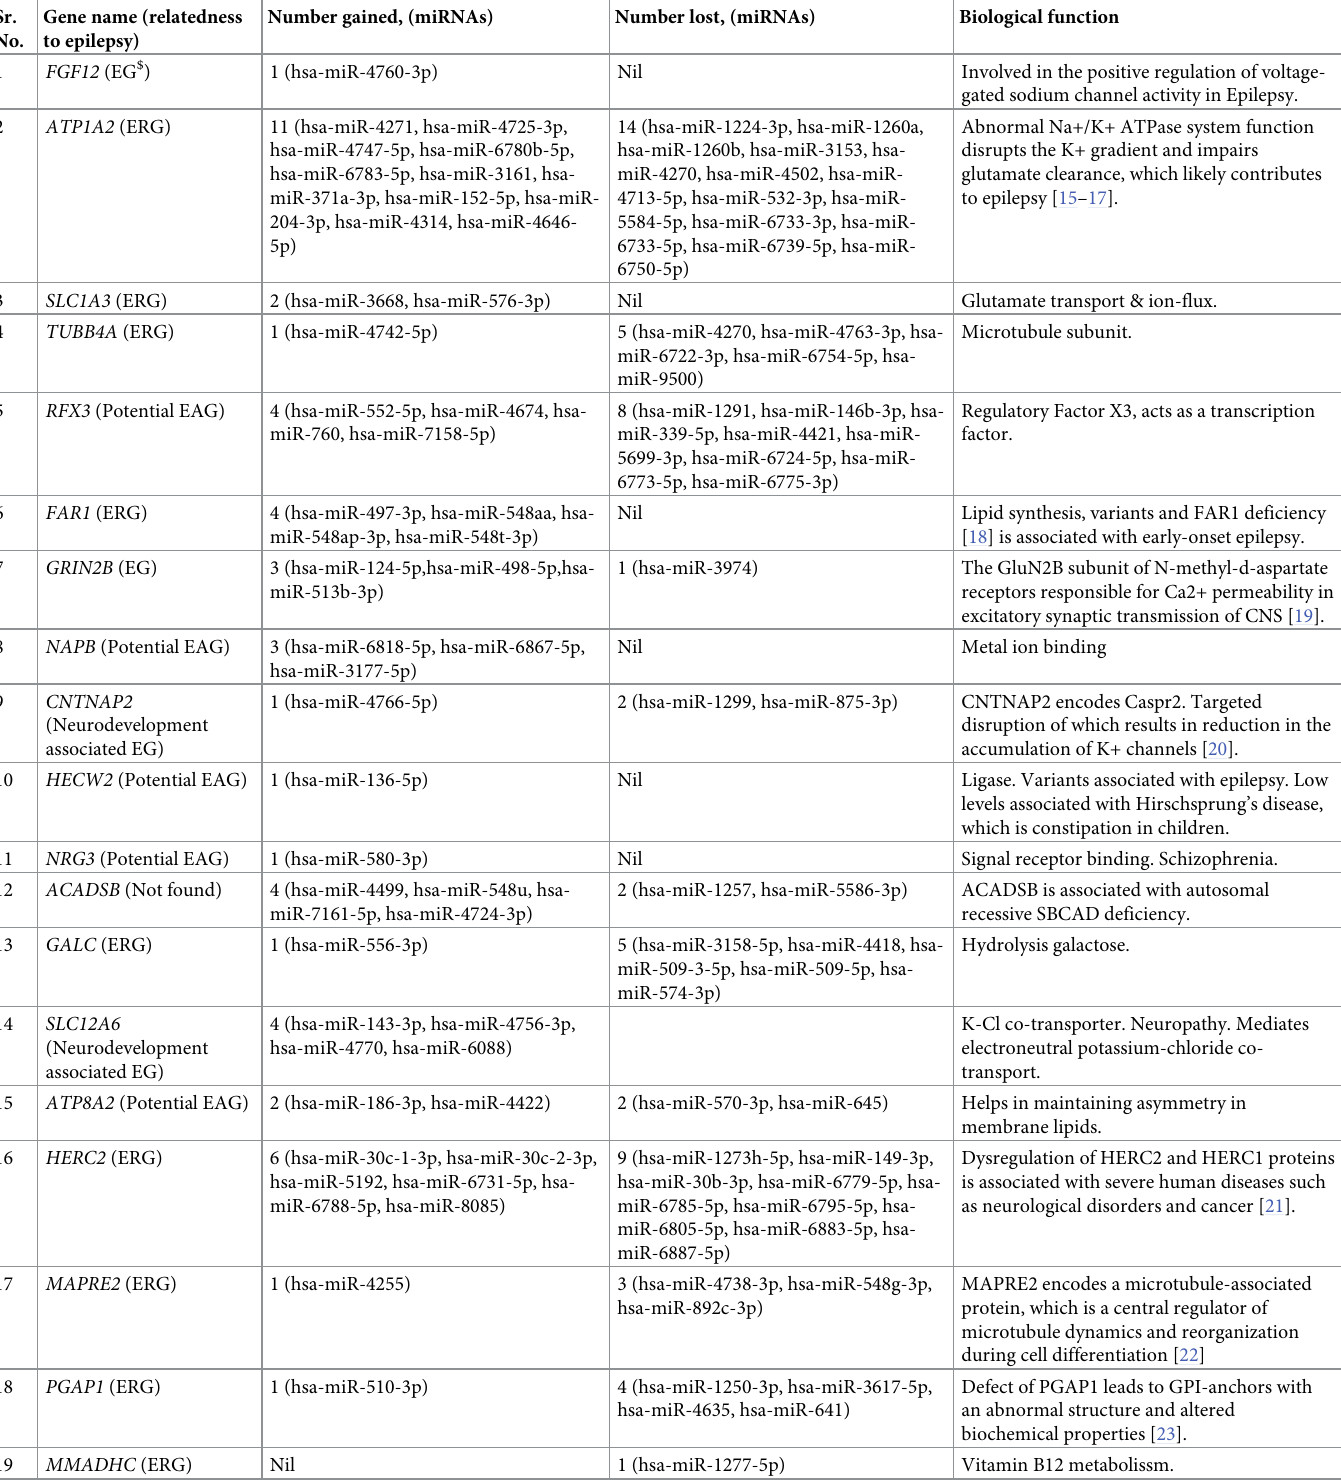
Table 2. Numbers of miRNA binding sites, gained and lost, due to observed SNVs in the 3’-UTR regions of the epilepsy-associated genes. Sr. Gene name (relatedness No. to